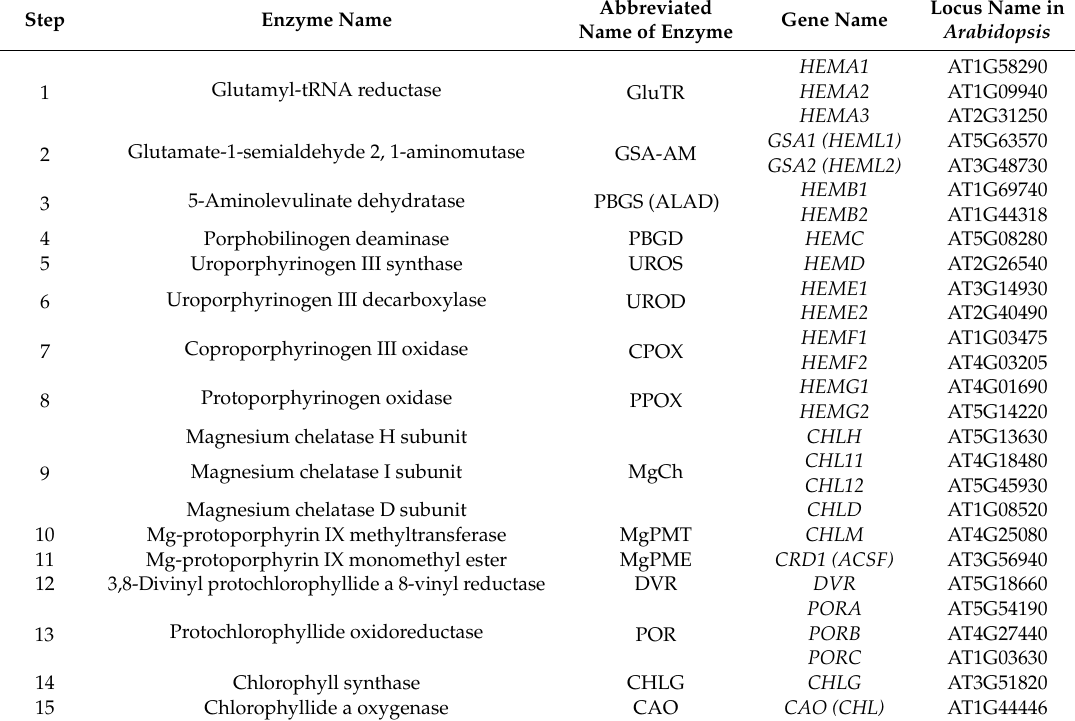
Table 1. Genes encoding and enzymes involved in the chlorophyll synthesis pathway in A. thaliana